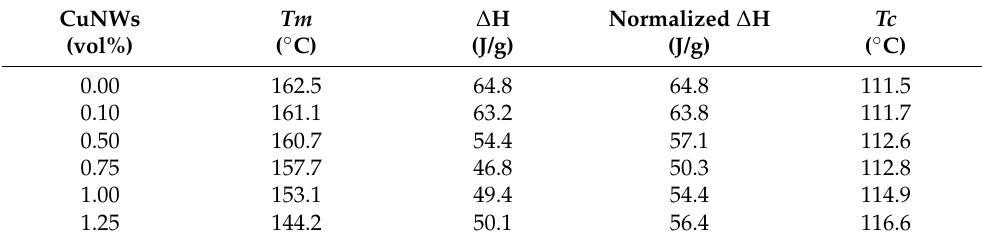
Table 2. The summary of thermal analysis for solution-cast i-PP/CuNWs